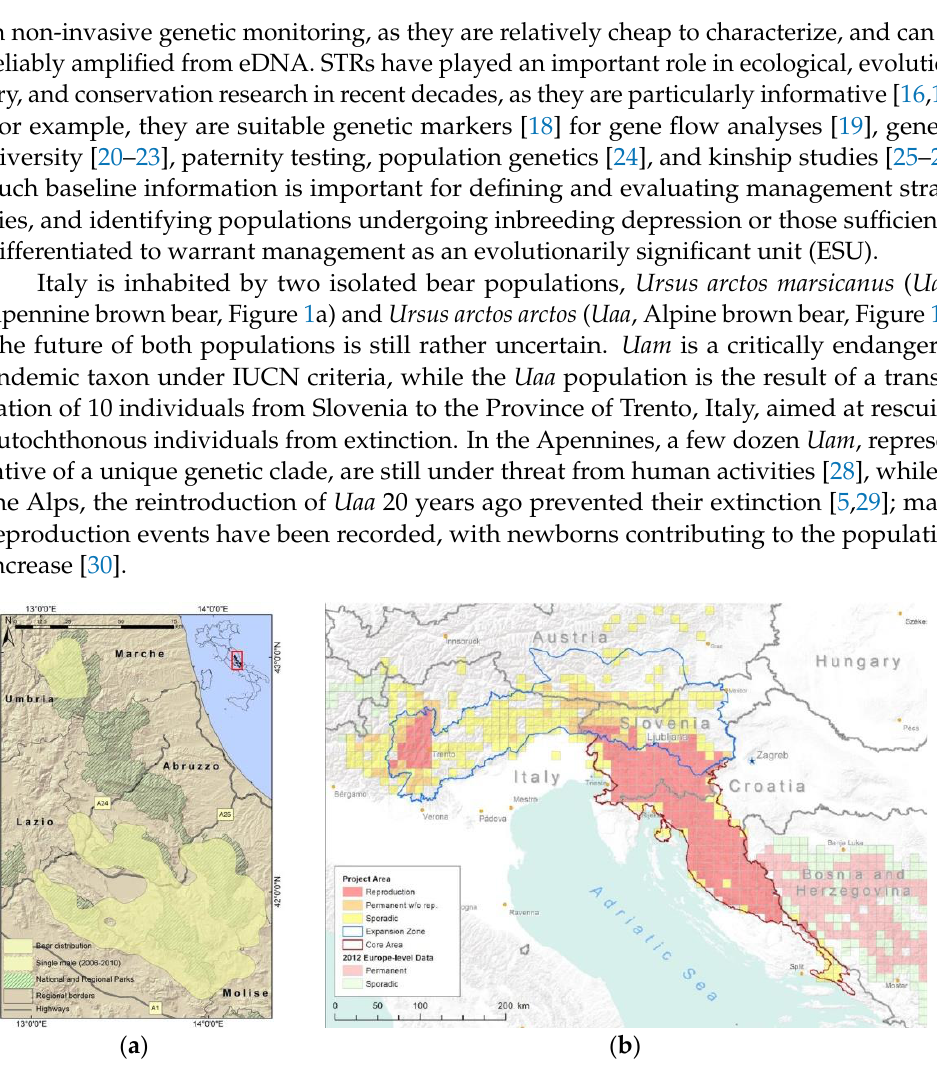
Figure 1. Brown bear ( U. arctos ) distribution in Italy and neighboring countries: ( a ) brown bear distribution in the Central Apennines ( Uam population), 2005 – 2014 (from [31]), the map of Italy provides a location reference at the country level (red frame); the main map provides a reference at the local level (Central Apennines); ( b ) brown bear distribution in the Alps ( Uaa population) and neighboring countries (from [32]).